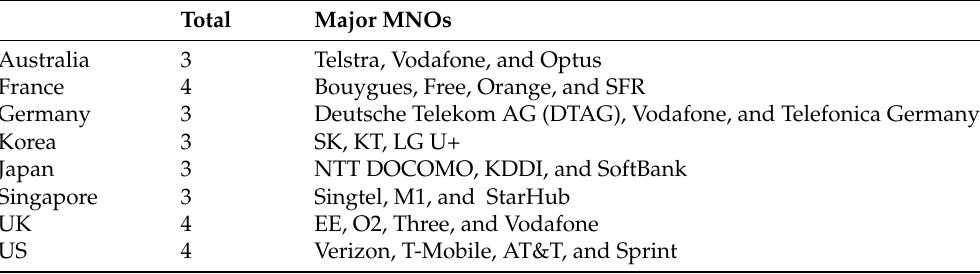
Table 3. Mobile network operators per country.